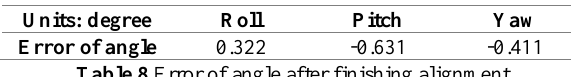
Table 8 .Error of angle after finishing